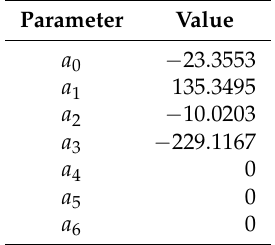
Table 1. Offline identified parameters of the current–voltage and current–power characteristics as a